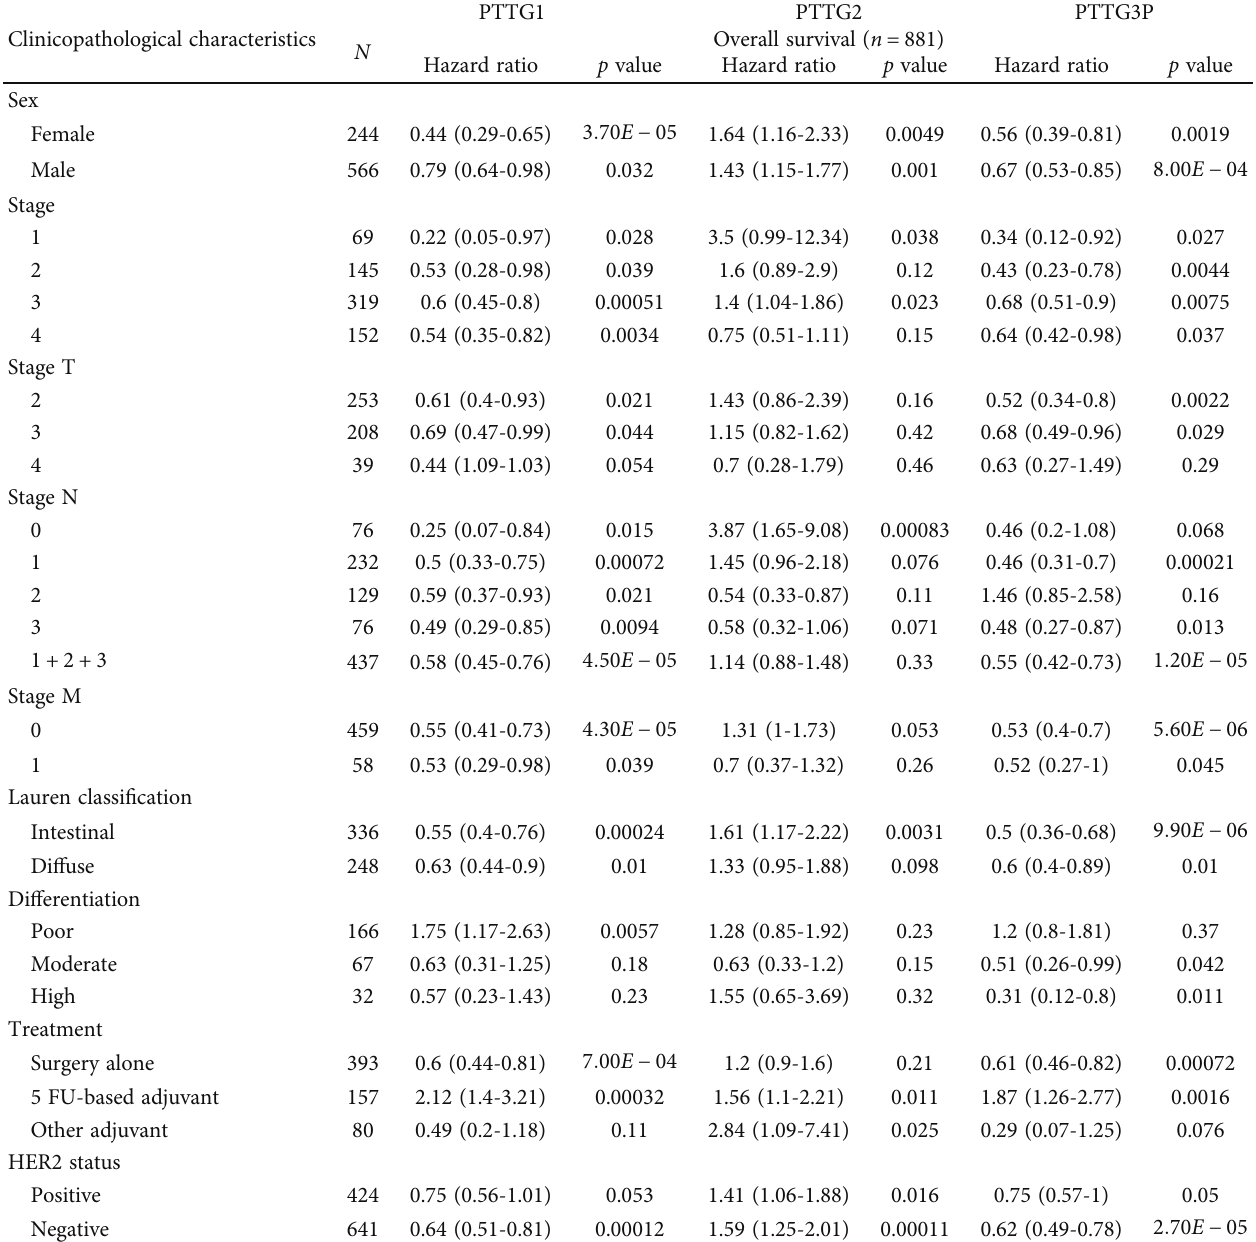
Table 2: Evaluation of the association between PTTG expression and clinical prognosis in gastric cancer using the Kaplan-Meier plotting method and other clinicopathological